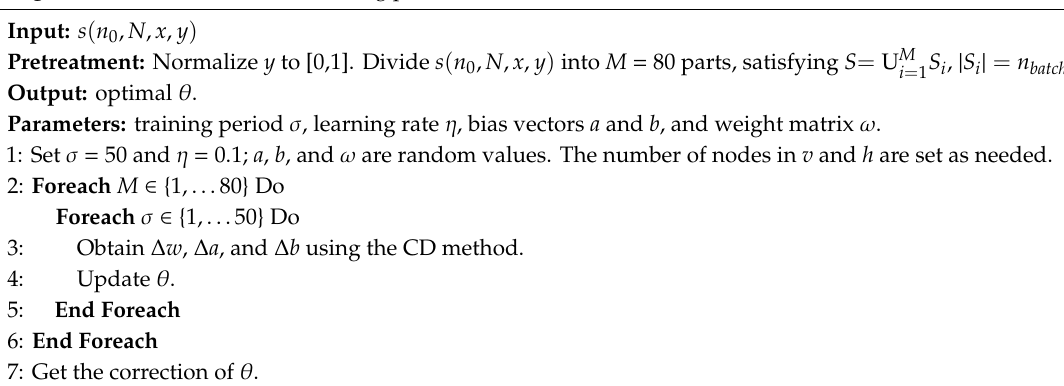
Algorithm 2. Method 2: RBM training